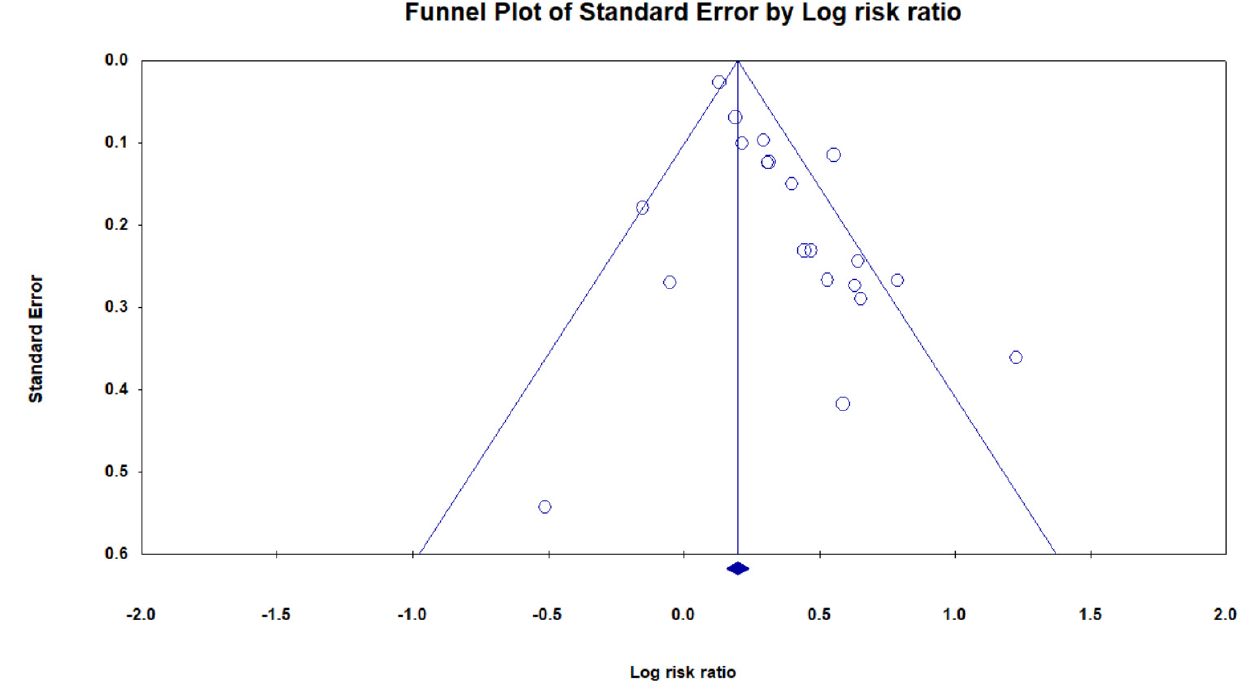
Figure 6. Funnel plot.